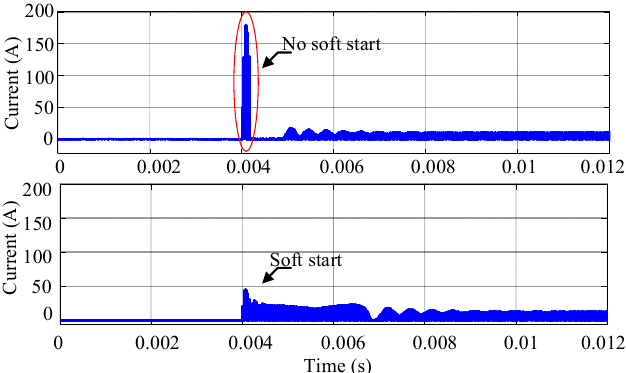
Figure 16. Comparison of secondary side output current with and without soft start.